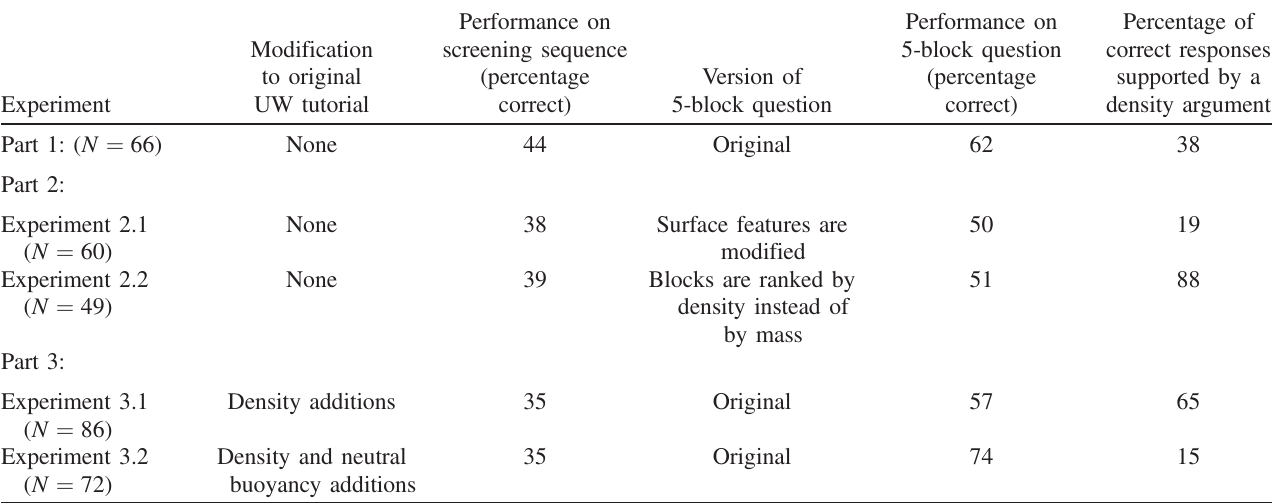
TABLE I. Student performance on the screening sequence and versions of the 5-block question over the five semesters of this study.